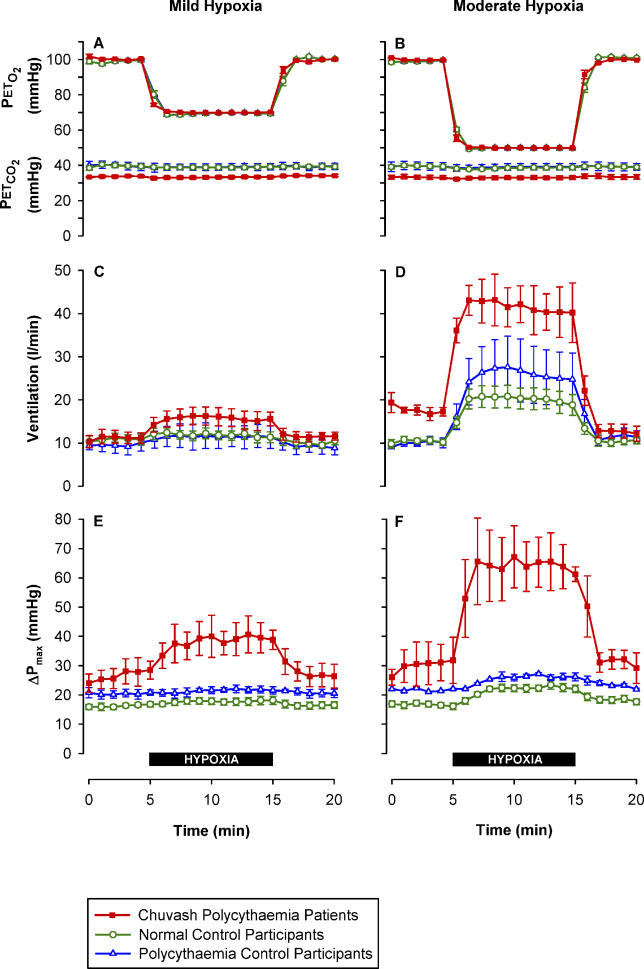
End-Tidal Gas Control, Ventilatory, and Pulmonary Vascular Responses to Mild and Moderate Hypoxia(A and B) End-tidal gas control.
Pet
O
2 and
Pet
CO
2 were well controlled.
Pet
O
2 was well matched between all groups.
Pet
CO
2 was lower in the CP patient group, reflecting this group's lower baseline air-breathing
Pet
CO
2.
(C and D) Ventilation, given at body temperature and pressure, saturated with water vapour. Mild hypoxia provoked an increase in ventilation of 4.4 l/min in the CP patients versus 1.6 l/min in normal controls (
p < 0.05), while moderate hypoxia induced increases of 24.5 versus 10.0 l/min in these two groups, respectively (
p < 0.05).
(E and F) Pulmonary vascular tone. This was assessed using Doppler echocardiography to determine ΔP
max, a standard non-invasive index of pulmonary vascular tone. With mild hypoxia, ΔP
max increased by 11.5 mm Hg in the CP patient group compared with only 1.1 mm Hg in the normal control group (
p < 0.05). Moderate hypoxia stimulated a rise in ΔP
max of 35.3 mm Hg compared with 6.1 mm Hg in these two groups, respectively (
p < 0.001).
All responses are shown during mild (A, C, and E) and moderate (B, D, and F) hypoxia. Values are mean ± standard error of the mean.